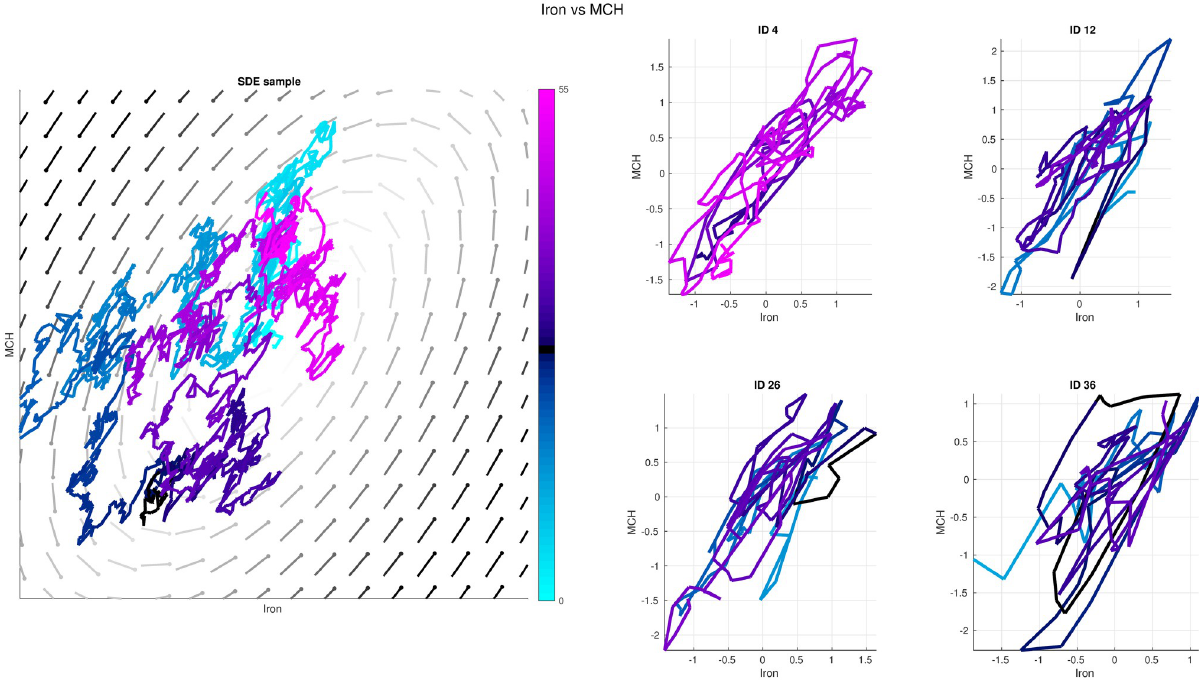
Fig 4. Model of Iron vs MCH: A. Here we illustrate the directed interactions between Iron (horizontal) and mean corpuscular hemoglobin (MCH) (vertical). The left-hand-side shows the phase-diagram associated with A , as well as a sample-trajectory from the SDE (including B ). Other sample trajectories are shown in Fig J in S1 Text. The right-hand-side shows several subplots from various dolphins (after kalman filtering to reduce the observation error). The colorscale refers to age (see inset colorbar).